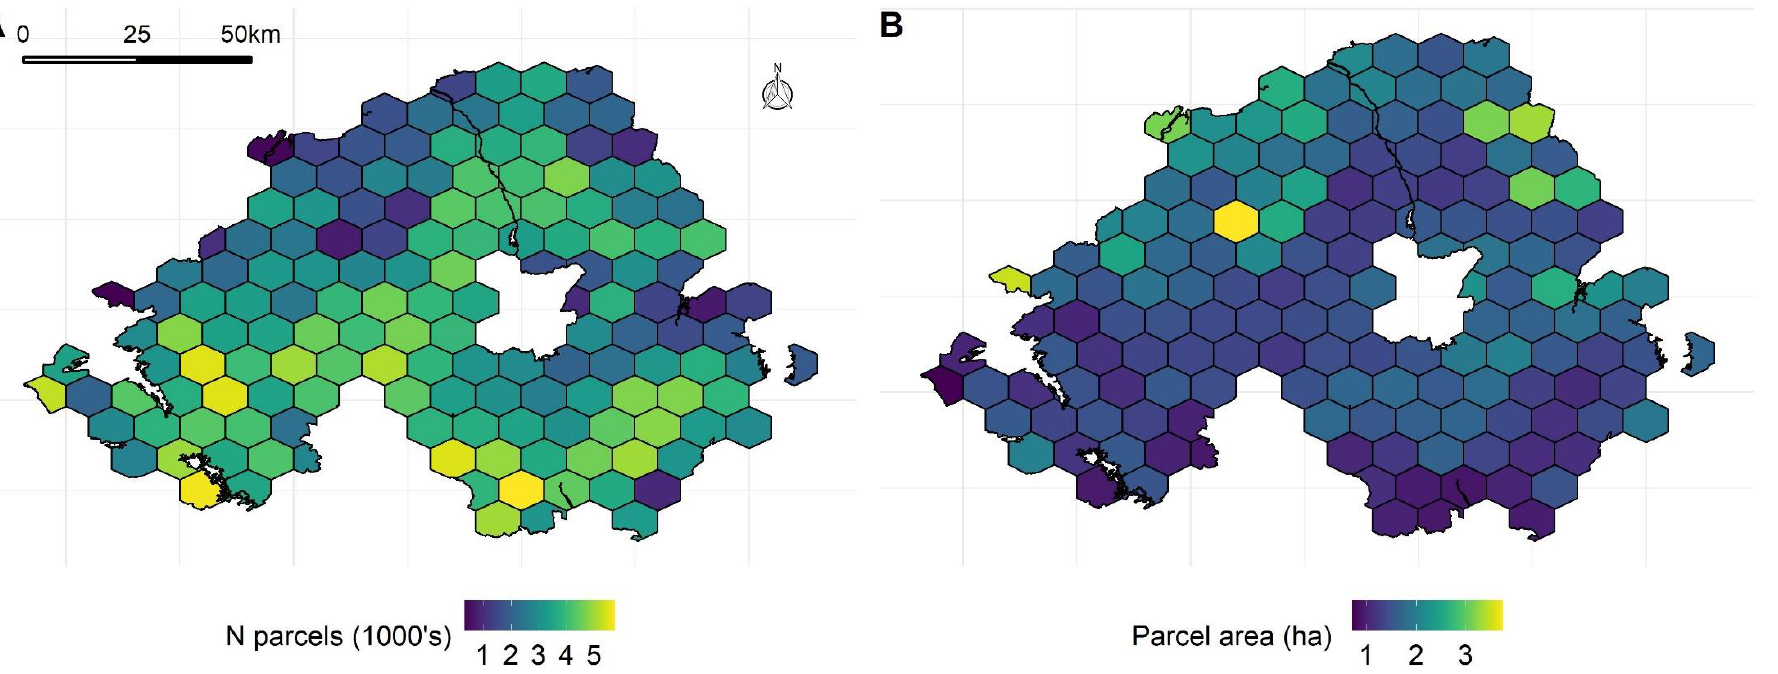
Figure 2. Hexagon plots showing ( A ) the number of land parcels associated with cattle farming per 10 km hexagon cell, and ( B ) the mean area of land parcels associated with cattle farming per 10 km hexagon cell.